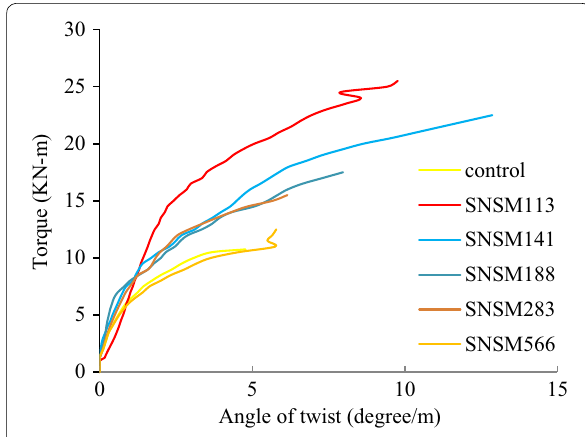
Fig. 12 Torque versus twist angle of each concrete